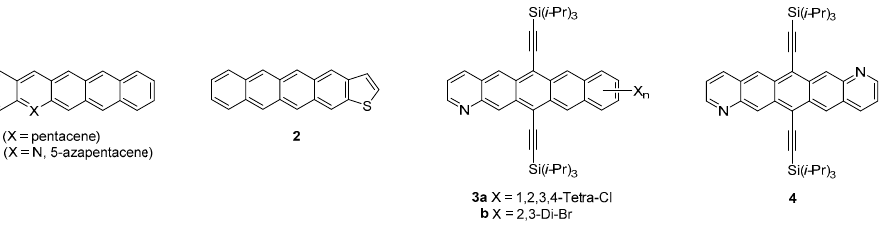
Figure 1. Pentacene and its isosteres.